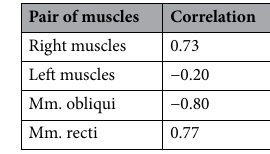
Table 3. Estimated correlation coefficients between the signal outputs obtained from various pairs of MC